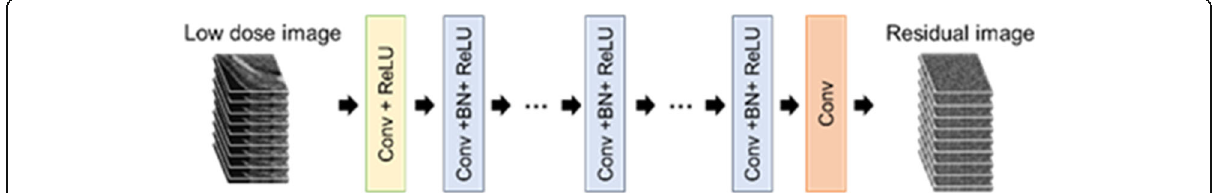
Fig. 1 Overall architecture of the DnCNN with simulated-noise images. This network learns residual mapping for noise image. The main modules include convolutional filtering, ReLU and BN